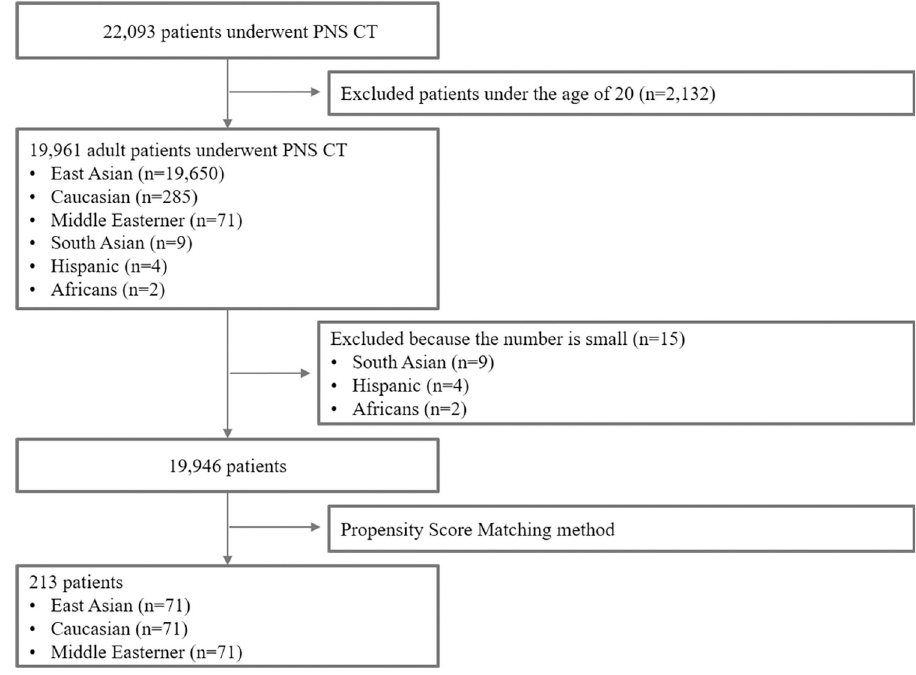
Fig 1. Flowchart of the study design.